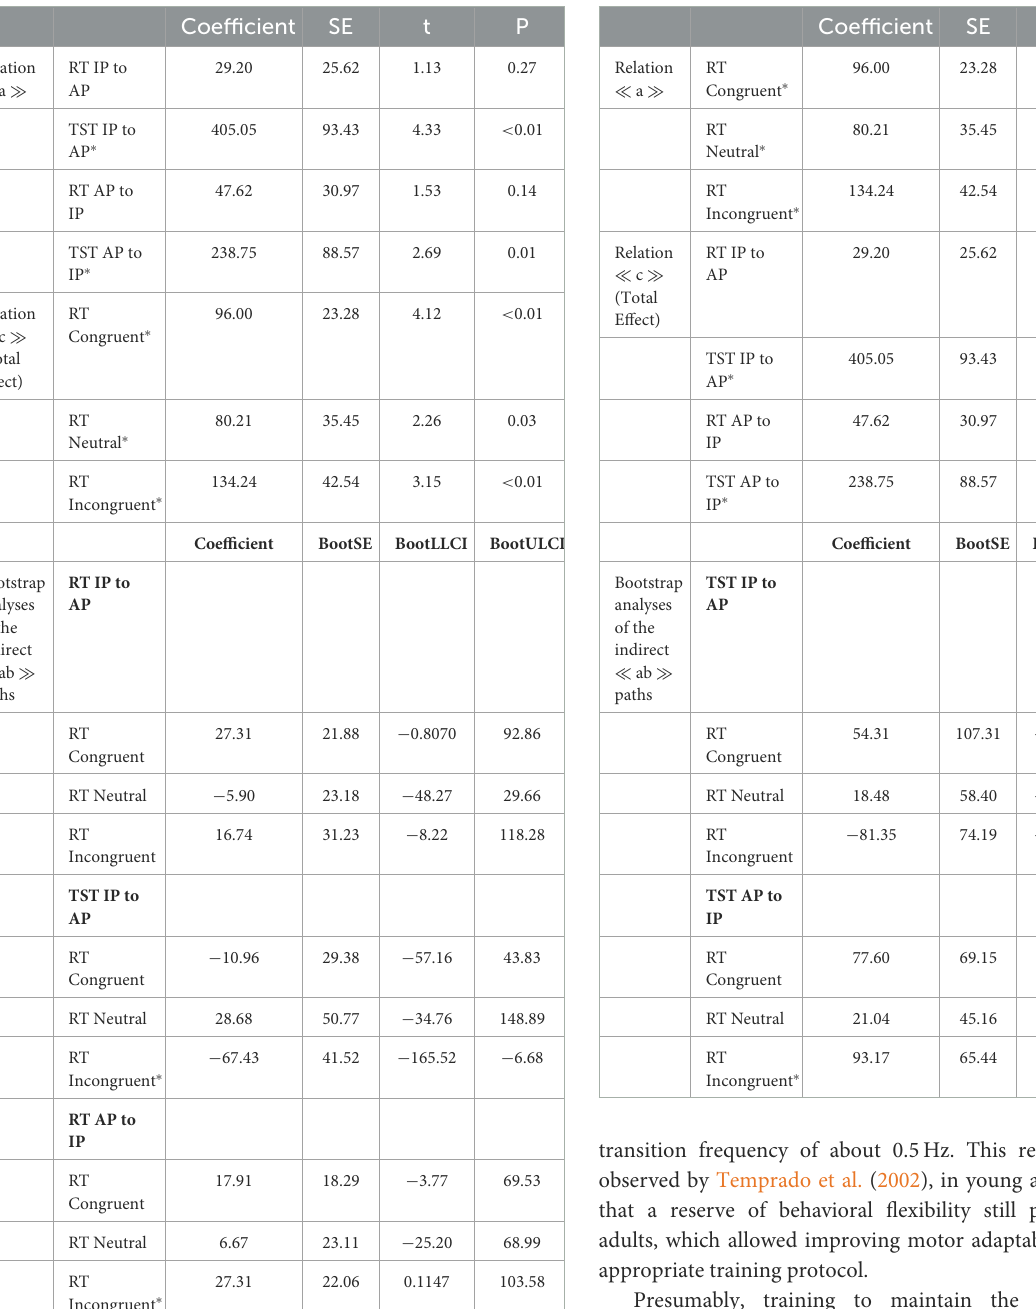
TABLE 3 Training-related enhancement of inhibition capacities as measured by the CSWT mediation through improvements in intentional switching variables (i.e., RT and TST) (unstandardized reported